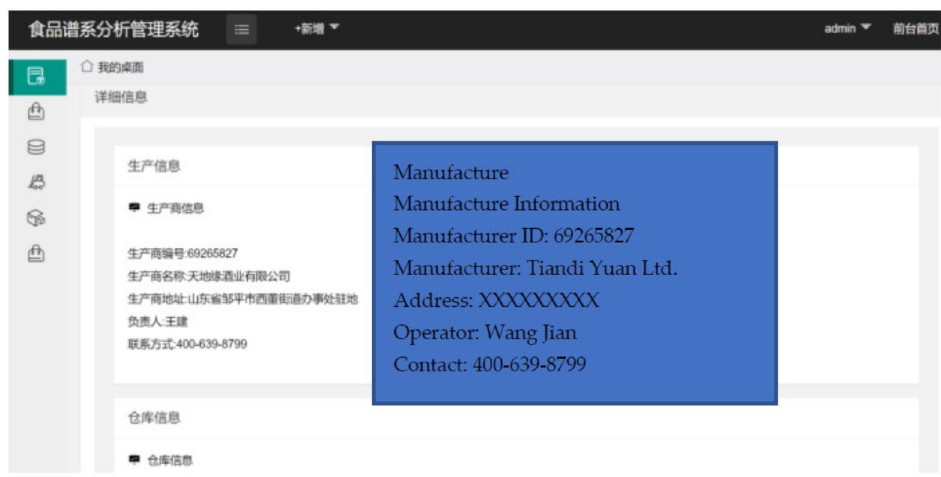
Figure 12. Detailed Information in Client Application.